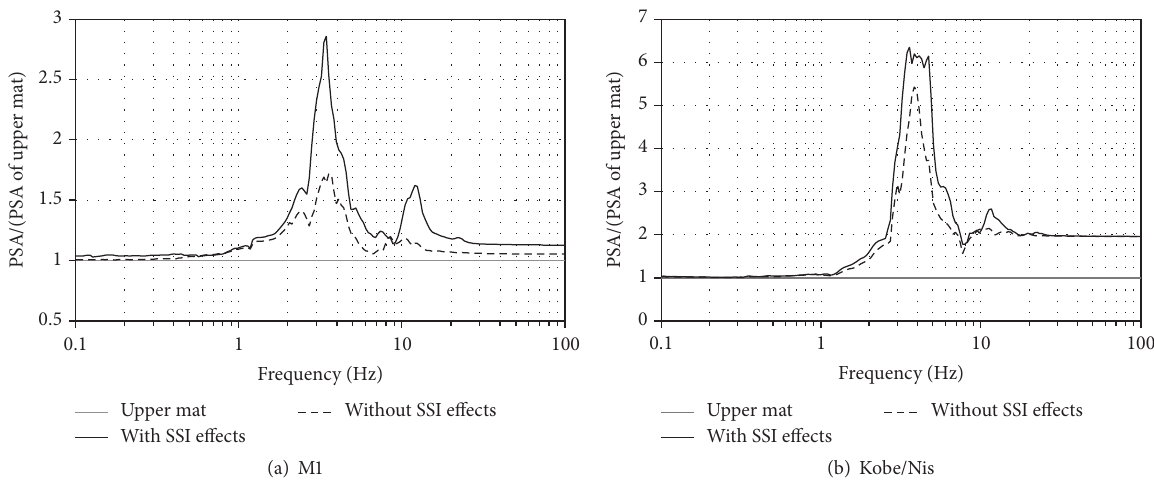
Figure 6: Comparison of the normalized response spectral acceleration for the top of the RCB and the upper